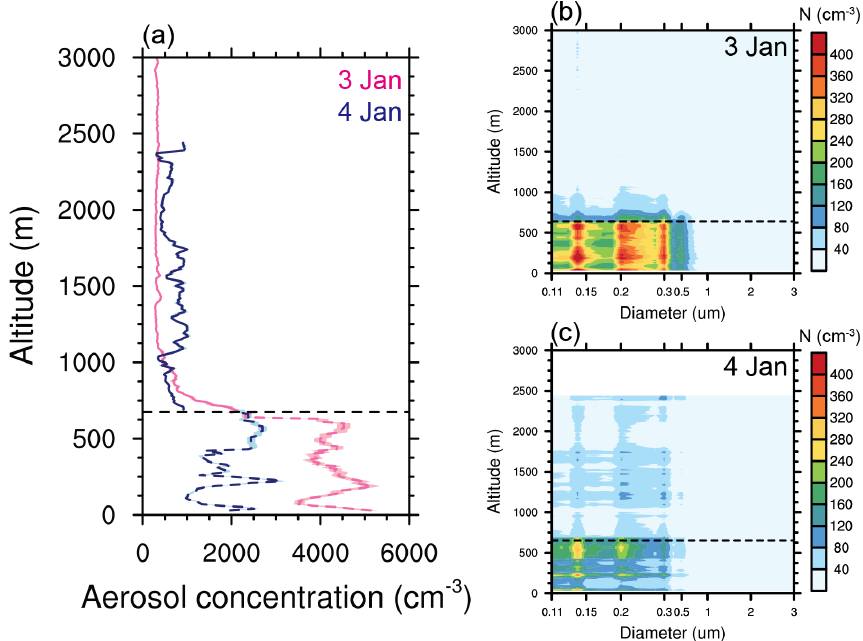
Figure 6. Aircraft observations of aerosol vertical distributions in the afternoon during the flight. (a) The aerosol number concentrations on 3 and 4 January. The dashed and solid lines denote the observations over Beijing and Baoding, respectively. (b–c) The aerosol size distributions on 3 and 4 January, respectively. The shaded areas in panel (a) indicate the error bars (standard deviation). The horizontal black dashed lines are the reference altitude of 650m.